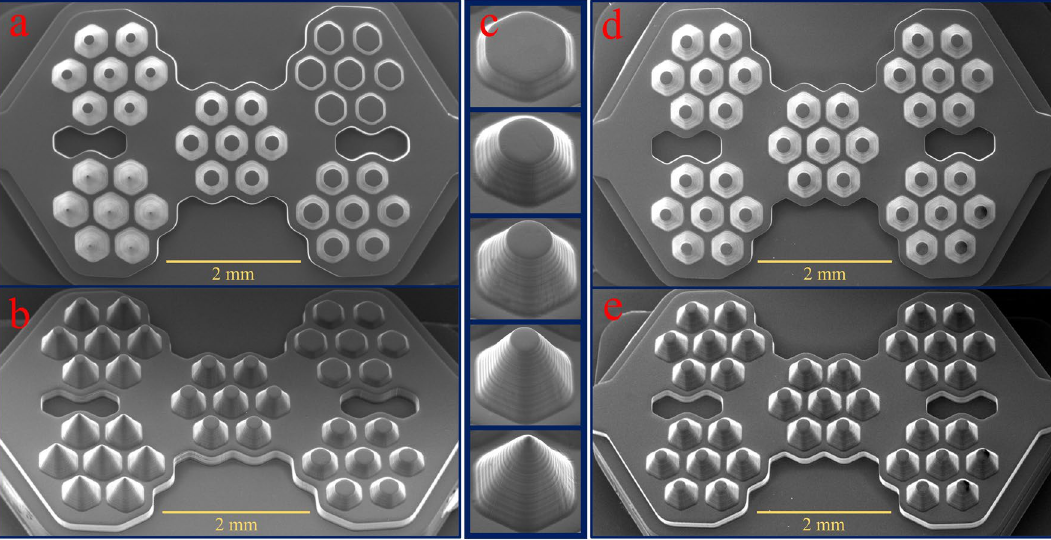
Figure 4. Scanning electron micrographs of 3D printed molds: ( a , b ) Top and side view of the mold with variable microwell heights. ( c ) Side view of the mold for different microwells from 100 to 500 µm. ( d , e ) Top and side view of the mold with constant microwell heights (300 µm).